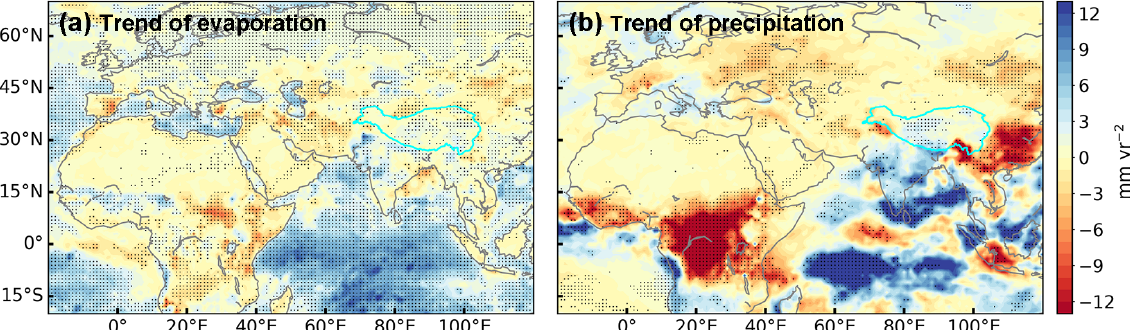
Figure 6. Long-term trends of annual ( a ) evaporation and ( b ) precipitation over possible source regions during 1979–2015. Stippling indicates regions with statistically significant trends ( p< 0 . 05).